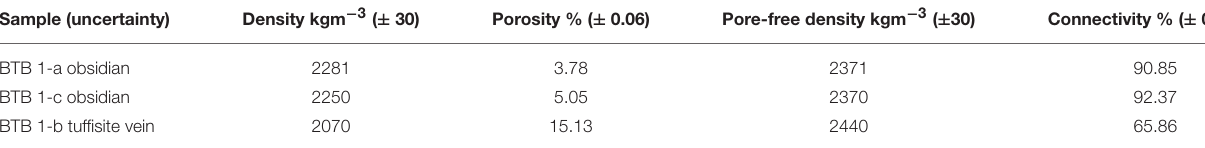
TABLE 1 | Bulk textural parameters for host obsidian and main tuffisite vein (see Figure 2A for measurement locations). Sample (uncertainty)